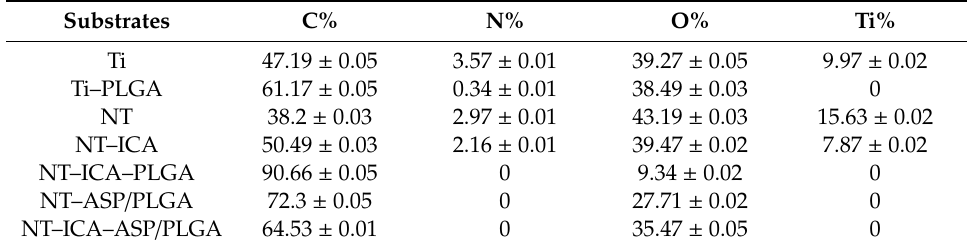
Figure 3. X-ray photoelectron spectroscopy (XPS) analysis displaying chemical composition of different surfaces. Table 3. Chemical compositions of samples measured by XPS.